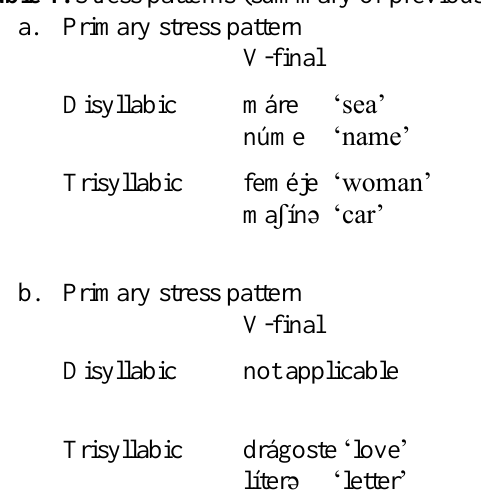
Table 1. Stress patterns (summary of previous